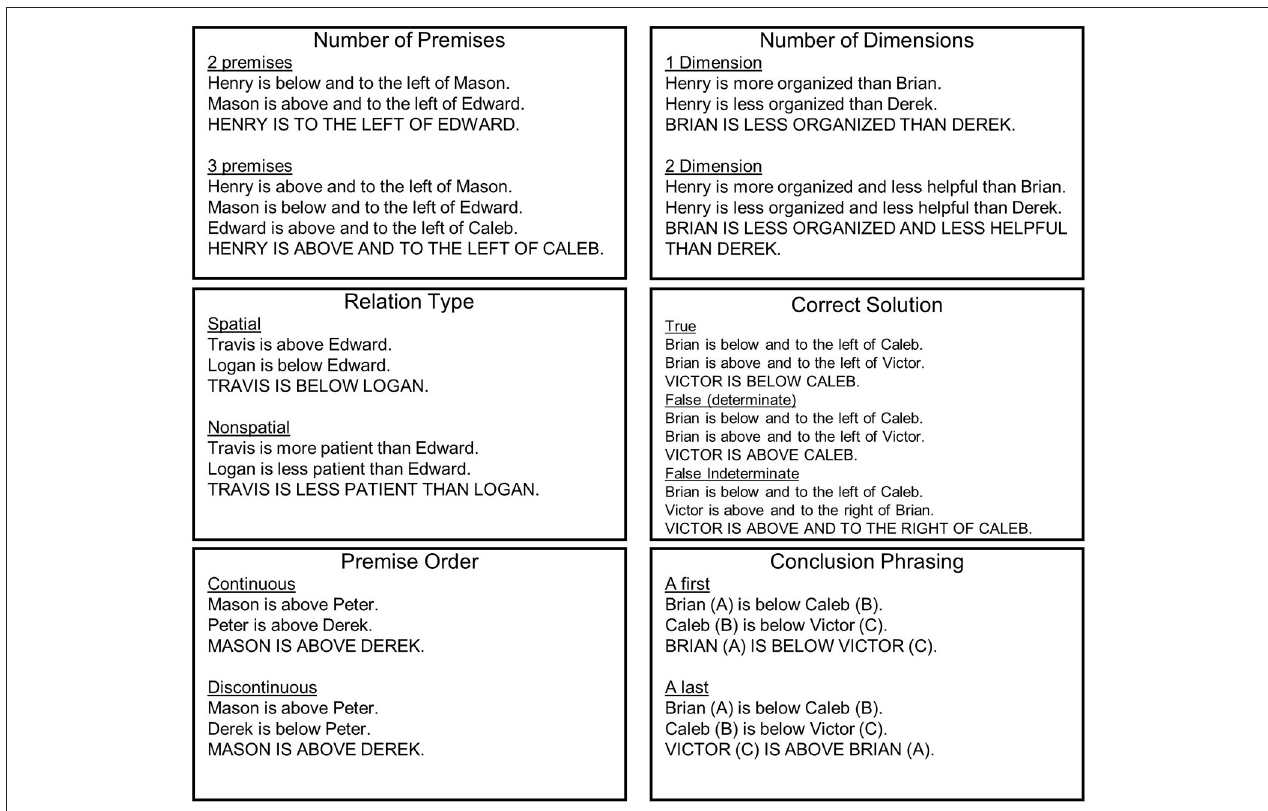
FIGURE 1 | Stimulus properties systematically varied in the